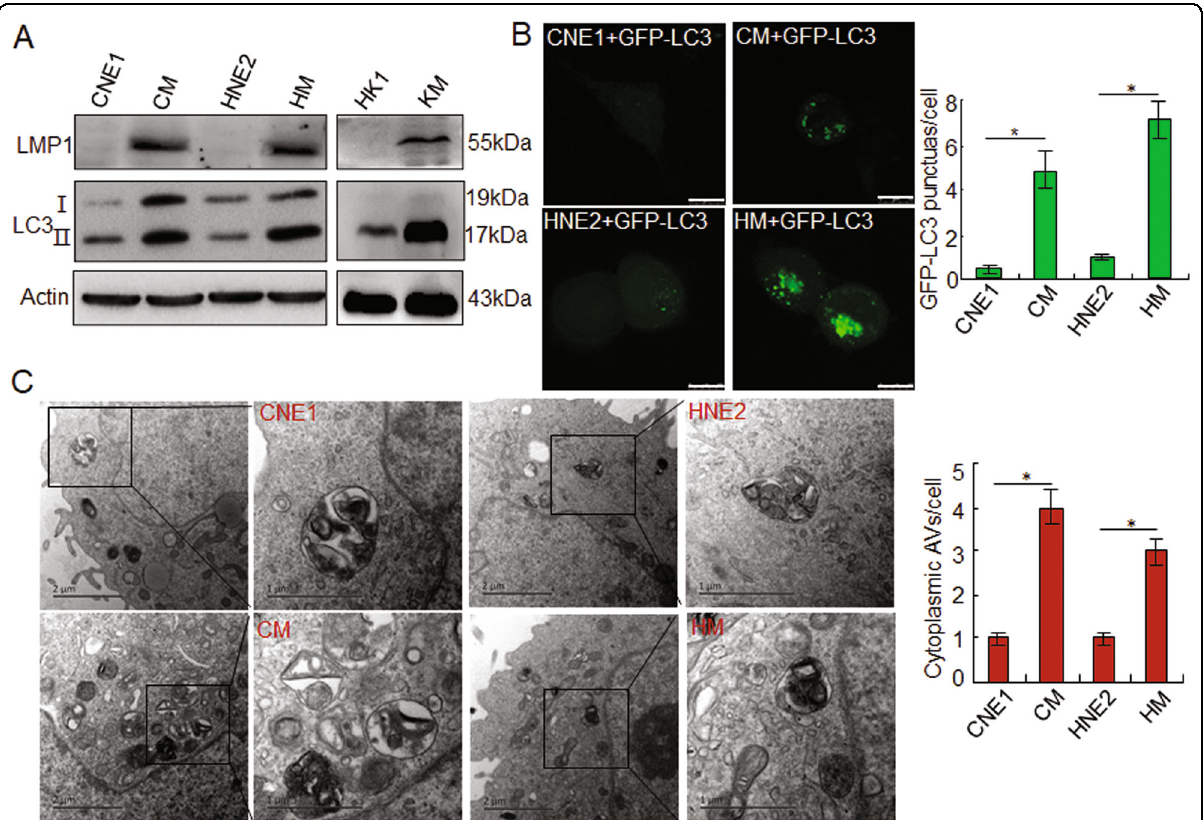
Fig. 1 EBV-LMP1 induces autophagy in NPC cells. A The expression of LMP1 and LC3 I/II in CNE1, CM, HNE2, HM, HK1, and KM cells by Western blots. B After transfection with GFP-LC3 for 24 h, accumulation of GFP-LC3 puncta in NPC cells. Scale bar: 10 μ m. C Transmission electron images of different NPC cells. Data are expressed as means ± S.D. of three experiments. * p <